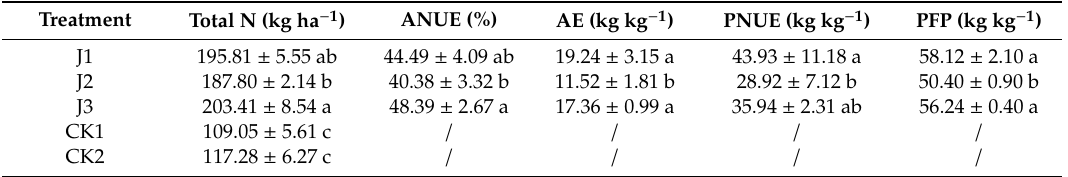
Table 3. Nitrogen utilization of rice under the applied fertilization